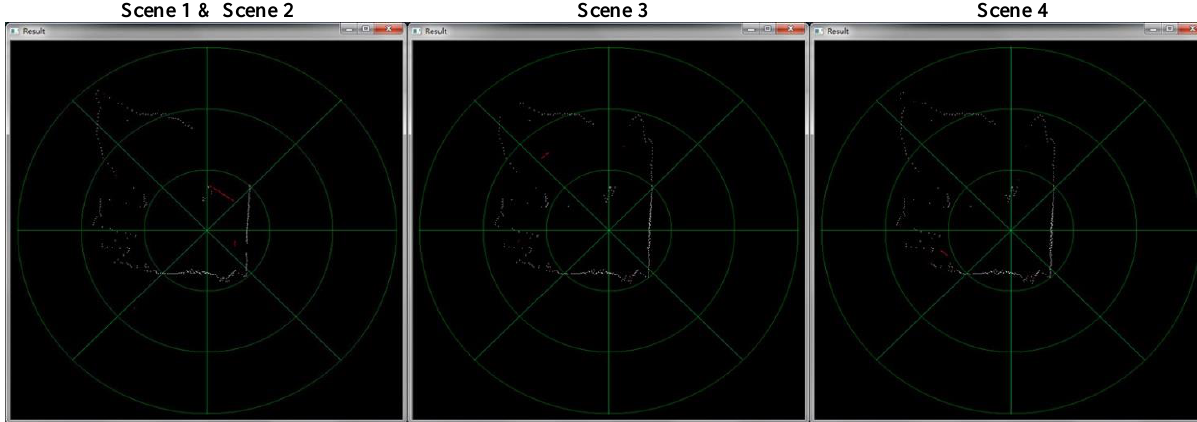
Figure 5. Detection result of the proposed method